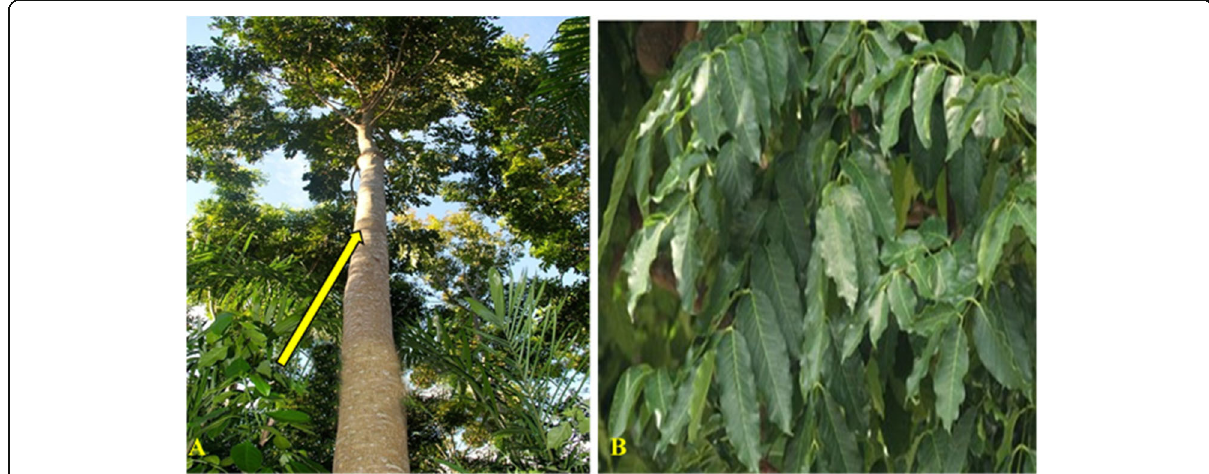
Fig. 3 K . grandifoliola . a Tree. b Leaves. Source: Google